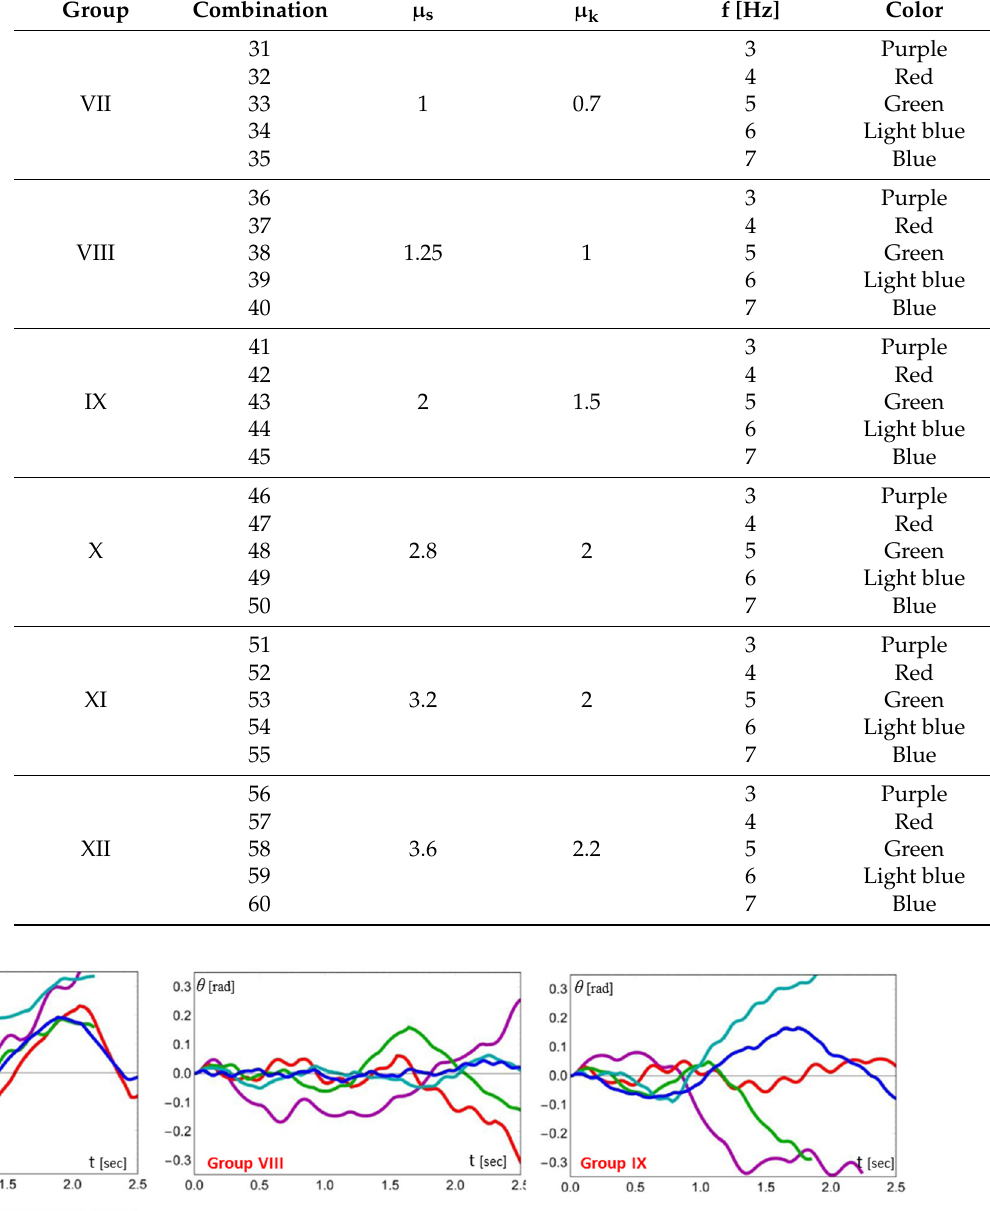
Table 3. Groups of combinations for a = 0.5 g.